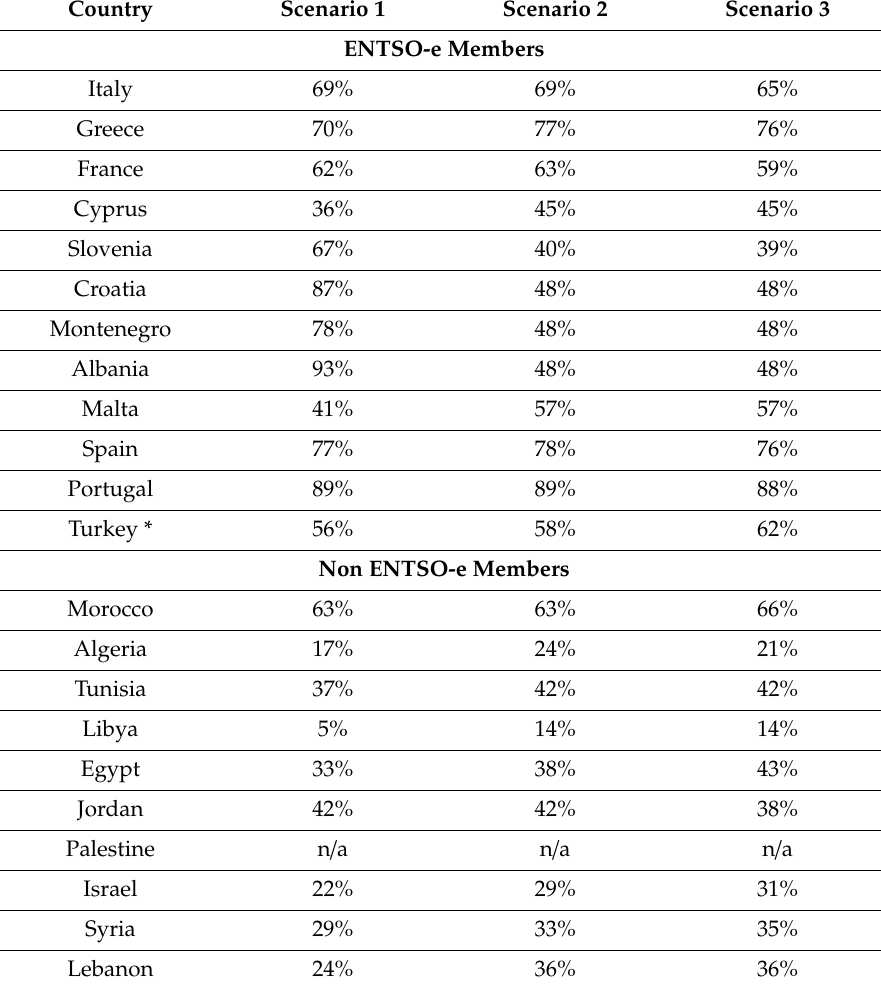
Table 2. RES proportion over total installed generation capacity for Scenario 1, 2 and